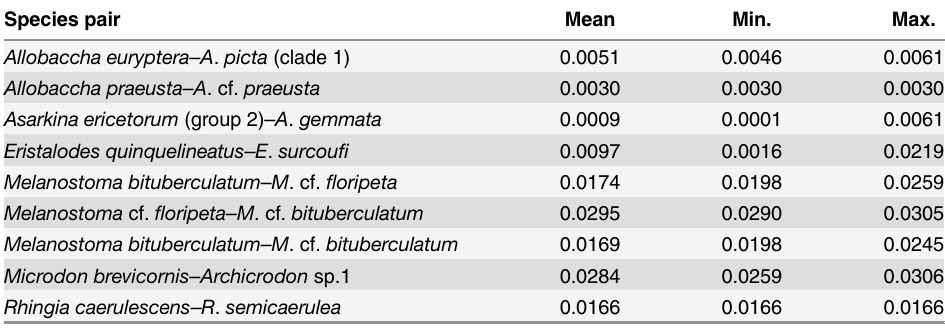
Table 1. Afrotropical hoverfly species pairs with small ( < 0.03) mean interspecific K2P COI sequence distance. Species pair Mean Min. Max.